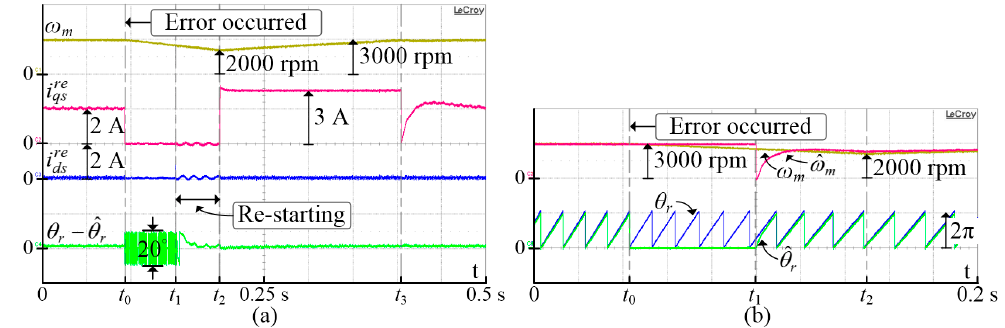
Figure 16. ( a ) Restarting of the motor from θ r = 90° with a positive speed under the rated load; ( b ) Amplified waveforms.